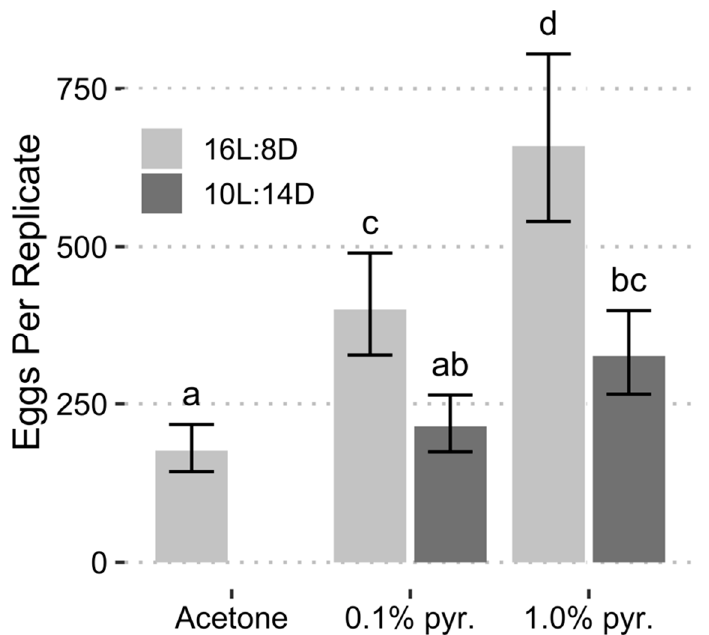
Figure 5. Egg production separated by chemical treatment (pyr. = pyriproxyfen) and photoperiod from the September collection. Error bars represent 95% confidence intervals. Bars with the same letter are not significantly different ( α = 0.05, estimated marginal means with Tukey’s method of adjustment for multiple comparisons).